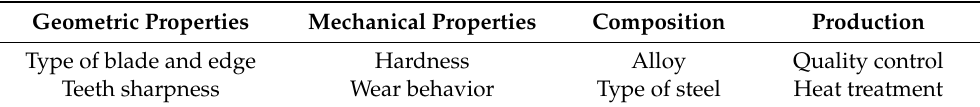
Table 2. Cutlery (especially knives) parameters influencing metal marking